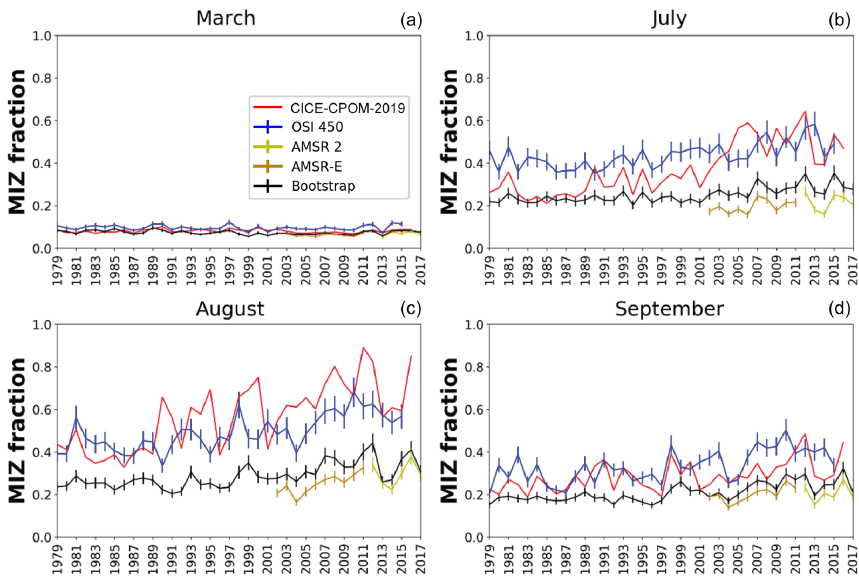
Figure 2. The same as Fig. 1 but instead showing the MIZ fraction for (a) March, (b) July, (c) August, and (d) September. Marginal ice zone extent is defined as the area where sea ice concentration is between 15% and 80%. Sea ice extent is the area of ice coverage above 15%. An error bar of 10% has been applied to the observational output. Table 3. Fraction changes of MIZ width needed for the MIZ area to remain constant compared to the calculated trends in MIZ width assuming an averaged perimeter.